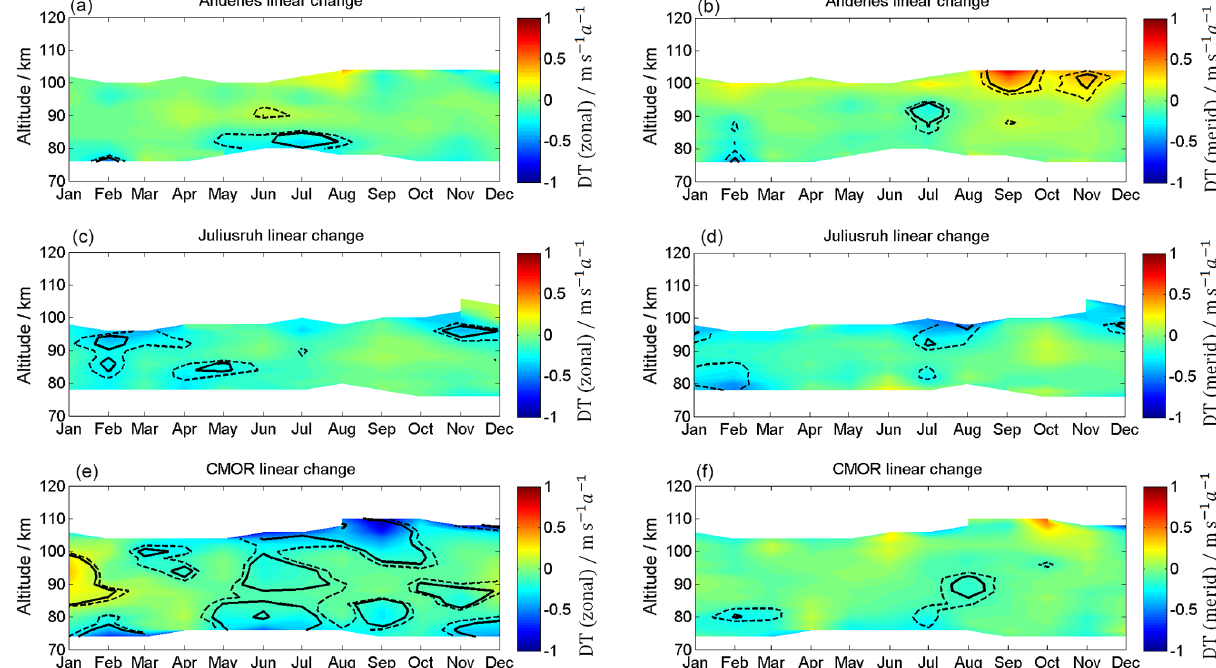
Figure 10. Linear long-term changes in zonal (a, c, e) and meridional (b, d, f) diurnal tidal components for Andenes (a, b) , Juliusruh (c, d) , and CMOR (e, f) . The solid black lines correspond to 95% significance, the dashed black lines to the 90%